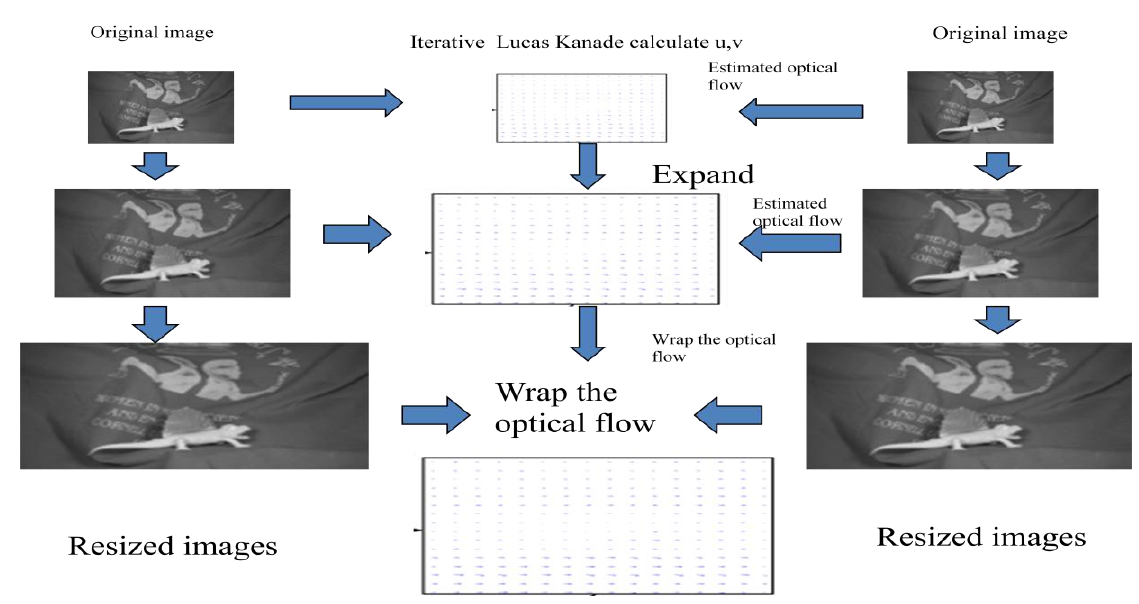
Figure 3. Coarse-to-fine optical flow